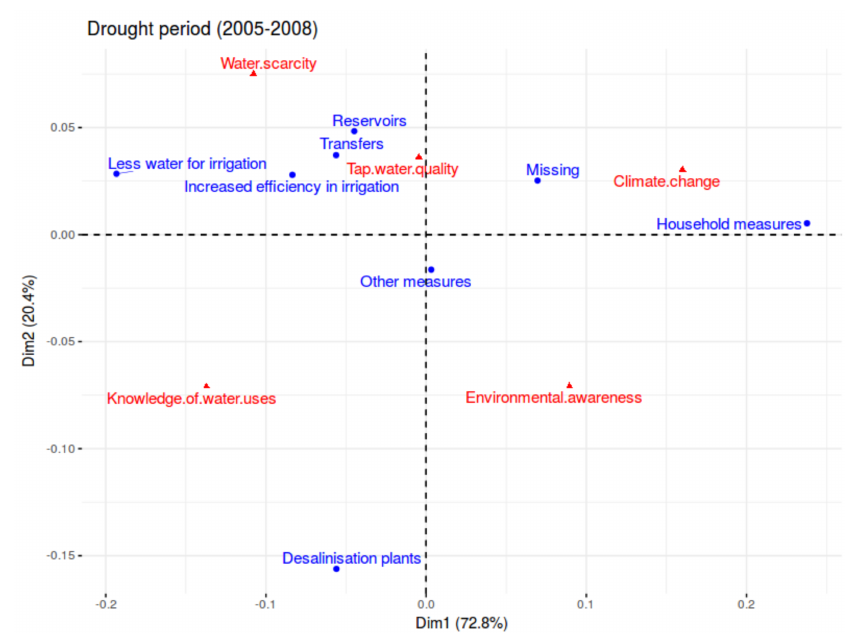
Figure 4. Correspondence analysis: context variables and public preferences concerning water management policies in the period of drought (2005–2008). Source: Authors’ own after EBA 2004–2013 (IESA-CSIC).